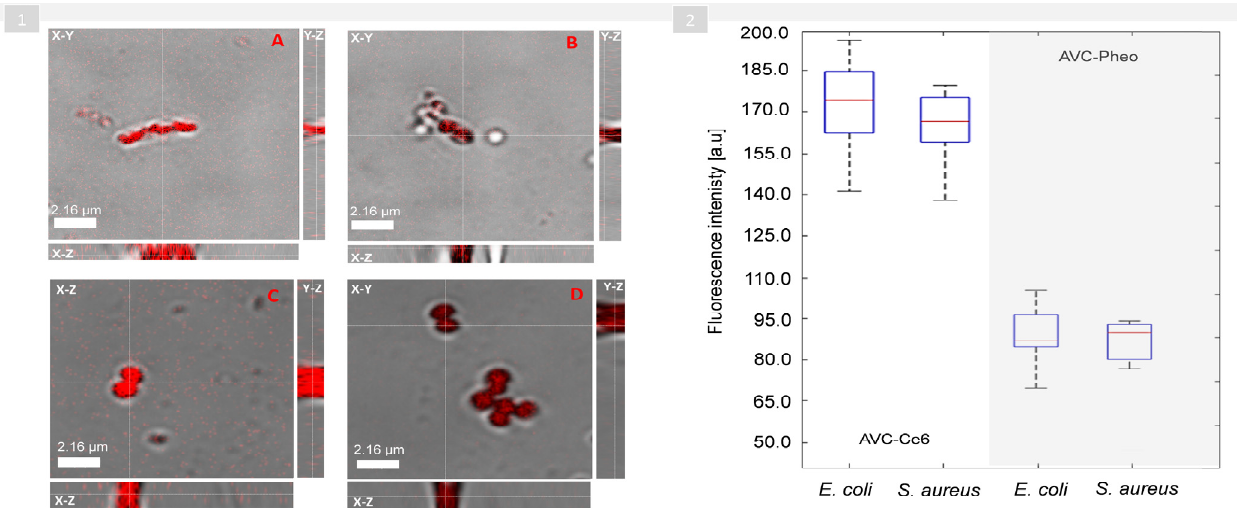
Figure 4. ( 1 ) Representative confocal 2D microscopic images (combined DIC-fluorescence images) of E. coli cells penetrated by Ce6 ( A ), Pheo ( B ), and S. aureus cells penetrated by Ce6 ( C ) and Pheo ( D ) photosensitizers; (white-dashed lines indicate the planes for which the axial (X-Z, Y-Z) cross-sections ( ∆ z = 3µm, with resolution: 0.04 µm) were extracted). ( 2 ) The boxplot representing the variation of the fluorescence intensity in the region of single cells.